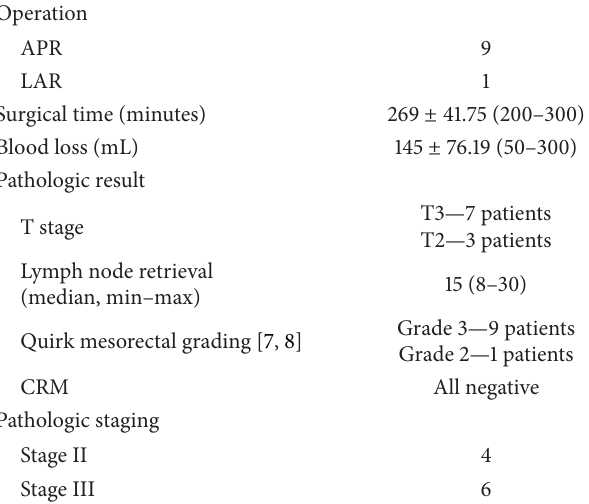
Table 2: Operation and pathologic result.